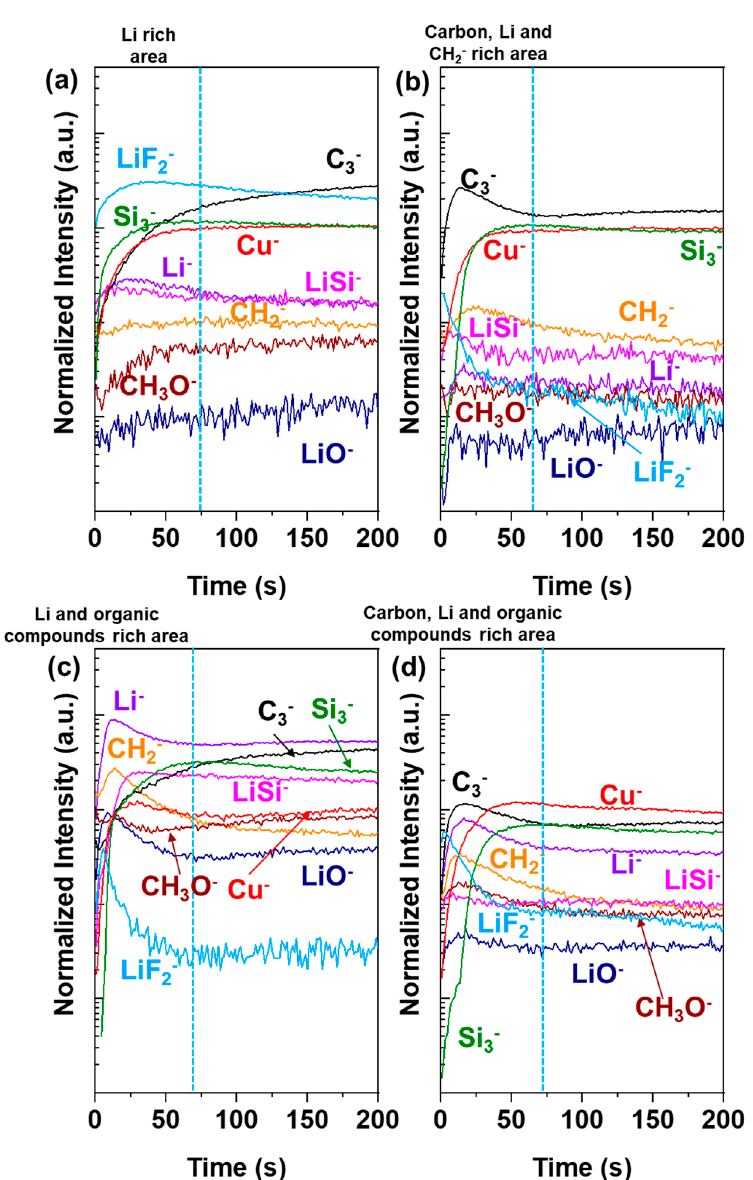
Figure 7. ToF − SIMS negative ion depth profiles for the Si − XG − AB electrode at ( a ) point 1 ( c ) point Figure 7. ToF-SIMS negative ion depth profiles for the Si-XG-AB electrode at ( a ) point 1 ( c ) point 2; 2; the Si@C − network electrode at ( b ) point 1 ( d ) point 2 (sputtering area 300 μ m × 300 μ m). the Si@C-network electrode at ( b ) point 1 ( d ) point 2 (sputtering area 300 µ m × 300 µ For the Si@C − network electrode at point 1 (Figure 7b), the LiF 2 − signal shows the max-